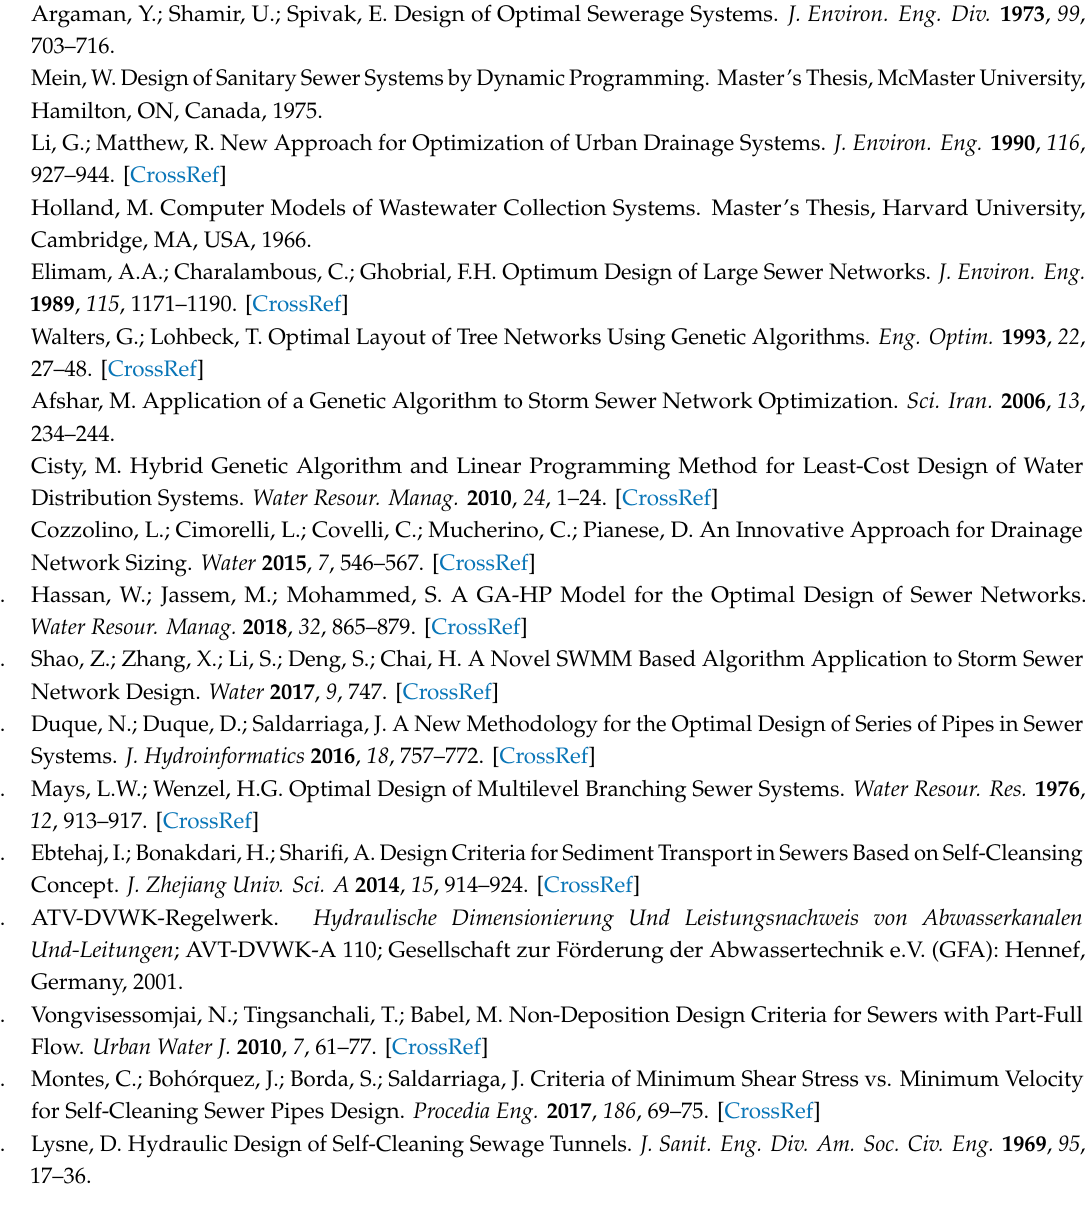
Table S1: Data for Mini-Chic ó sewer network, Table S2. Data for Mays and Wenzel [13] network, Table S3. Data for Table S5. Second simulation scenario for the sensitivity analysis, Table S6. Third simulation scenario for the sensitivity analysis, Table S7. Fourth simulation scenario for the sensitivity analysis, Table S8. Fifth simulation scenario for the sensitivity